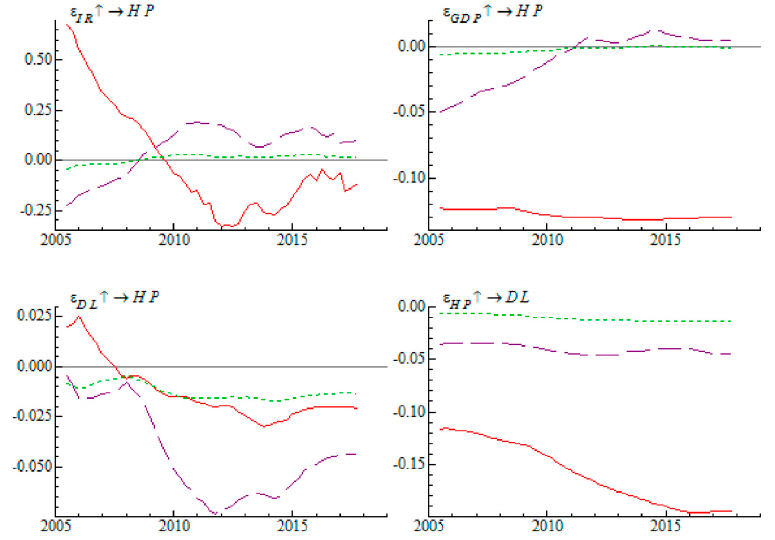
Figure 11. Impulse response for three different horizons. Notes: This shows the impulse response of the TVP-VAR model for the variable set of (IR, GDP, DL, HP); HP represents the housing price, DL represents real estate development loans, and IR represents the interest rate; the solid line refers to time-varying impulse responses for each quarter, the dashed line refers to half-year responses, and the dotted line refers to yearly responses.